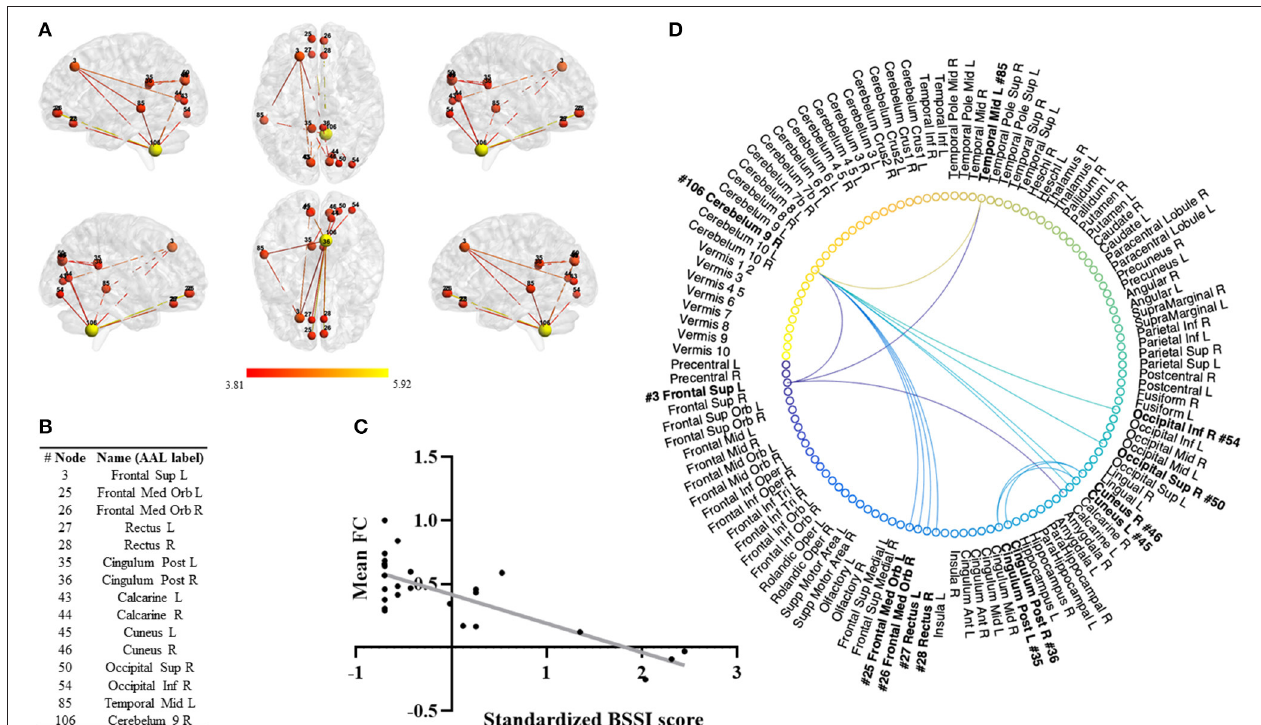
FIGURE 2 | Network Based Statistics (NBS). (A) Significant negative correlation between suicidal ideation and a functional connectivity network (adjusted for age, sex, and years of education) using the NBS method. Network presented for the significant threshold p = 0.001, t (threshold) = 3.78, df = 23, p -value (network) = 0.025, 15 nodes and 15 edges. (B) Nodes comprising the network and the correspondent AAL label. (C) Scatterplot illustrating the negative correlation between FC and suicidal ideation for each patient. The x-axis represents average values of FC and y-axis the standardized suicide ideation severity score on BSSI. The gray line represents the overall regression line. (D) Circular graphical representation of the nodes and edges of the